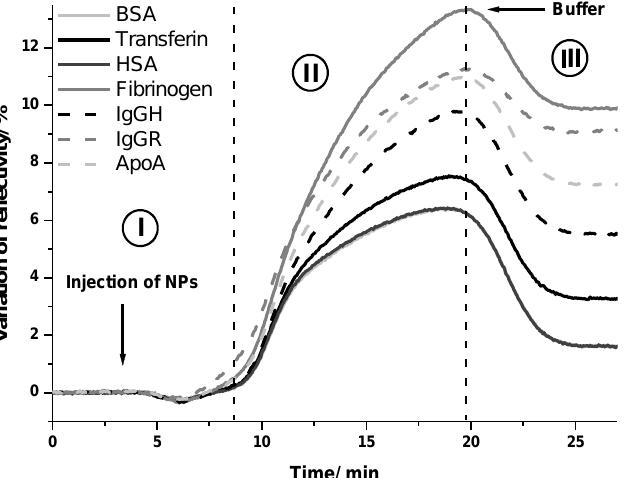
Figure 7. Kinetic curves of the interaction between gold NPs and proteins. Average of the variation of reflectivity on the protein spots under gold NPs injection in the SPRi. The same assay was repeated with silver NPs. The analysis of the kinetic curves allowed us to infer the affinity of each protein with gold and silver NPs. The proteins with high affinity should bind to NPs more strongly than the proteins with low affinity.